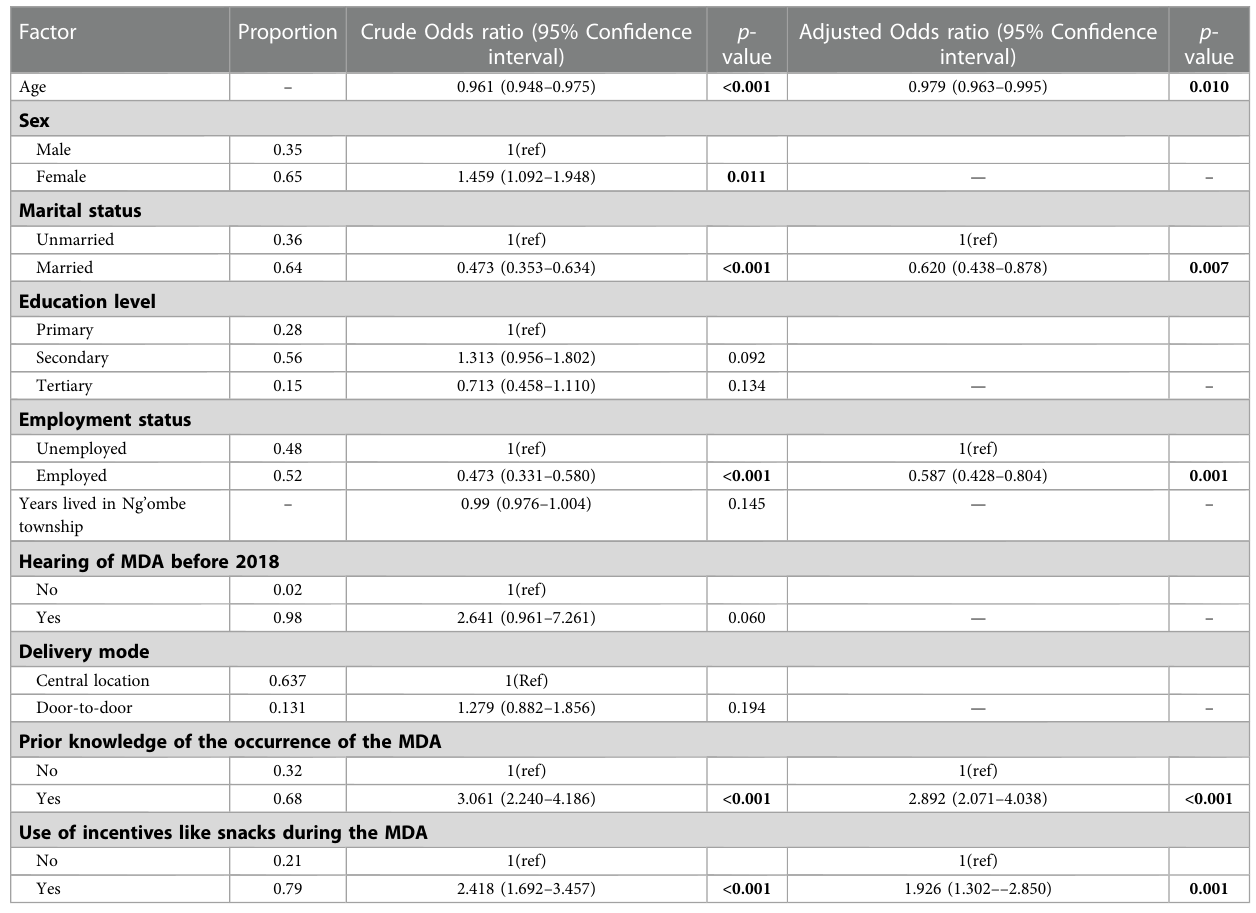
TABLE 2 Non-adjusted and adjusted logistic regression estimates of the uptake of the MDA against each potential predictor variable.